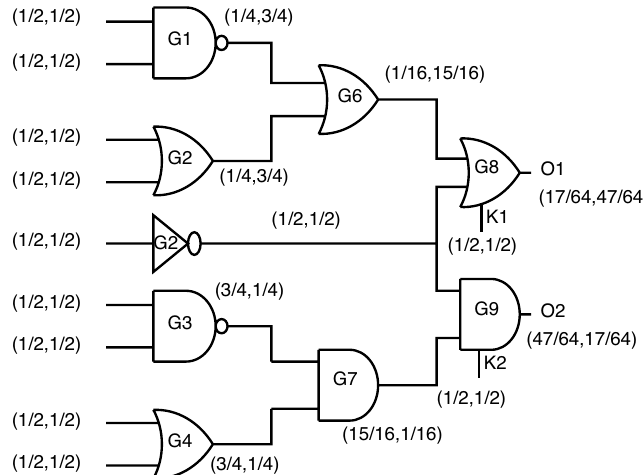
Figure 26. Case-1: Probability analysis using proposed